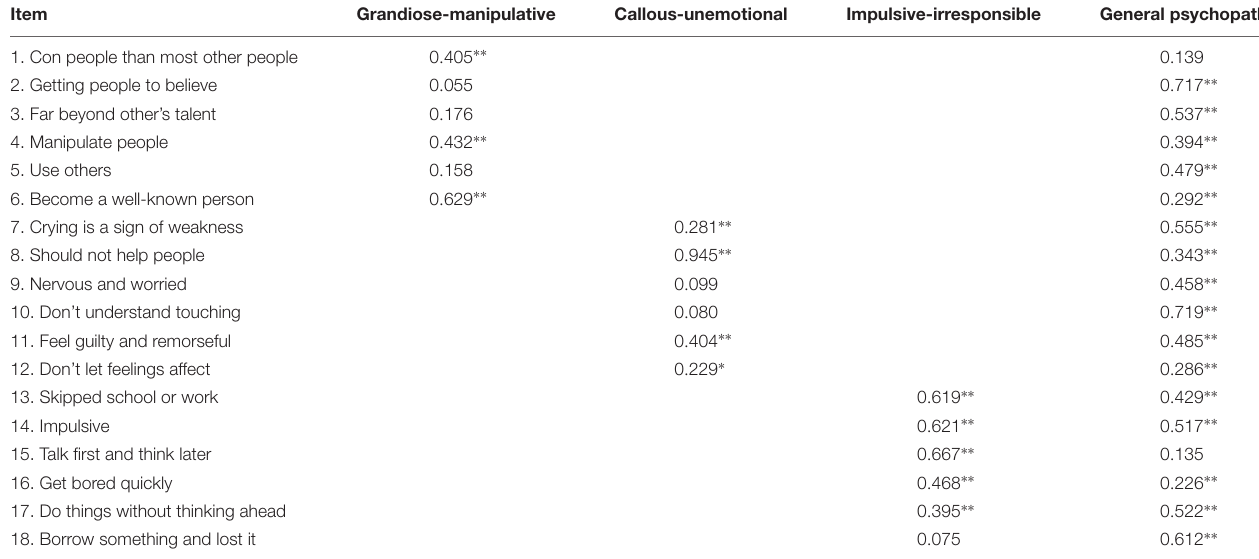
TABLE 3 | Factor loading based on bifactor model for the YPI-CV. Item